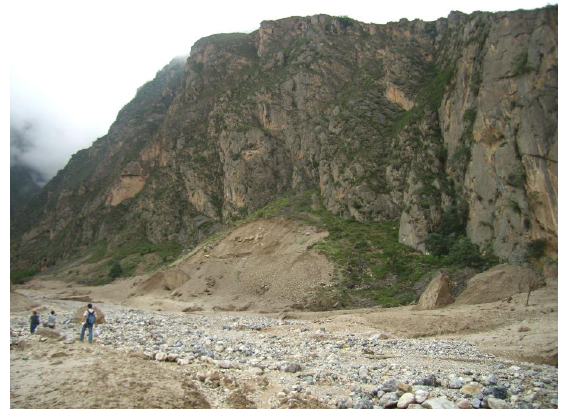
Fig. 7. Colluvial deposit derived from rockfall. The erosion by the massive and rapid debris flow resulted in colluvium failure producing more sediment volume for the debris flow. 4